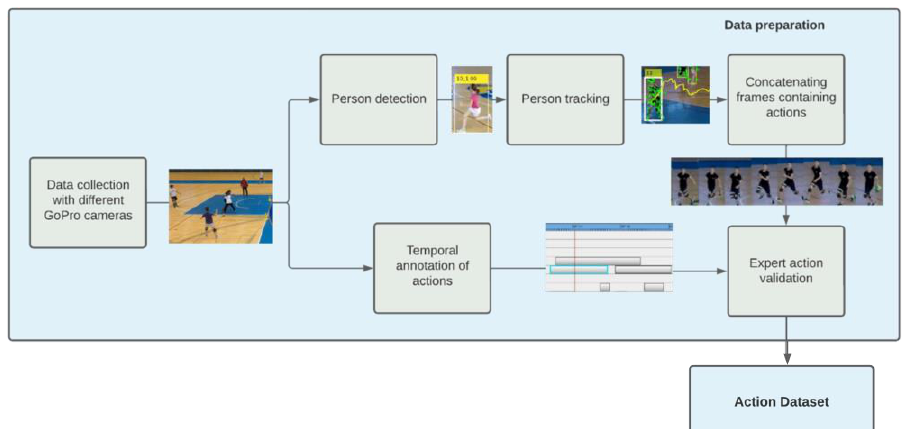
Figure 1. The semi-manual semi-supervised action dataset creation: the annotation of the data set includes manual temporal labeling followed by automatic spatial localization of players by means of automatic player detection and tracking, and finally, manual verification of generated action proposals.